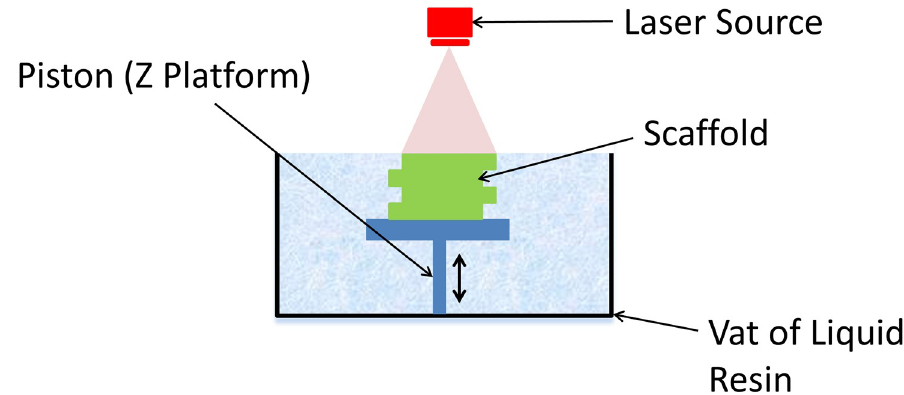
Figure 3. Schematic of stereolithography (SLA) printing process. The laser source cures the top of the liquid resin in a predetermined pattern. The platform is then lowered by the height of the cured resin and the process is repeated.